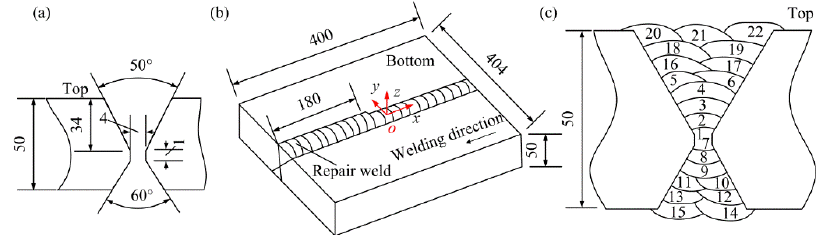
Figure 1. Schematic diagram of the specimen. ( a ) Groove configuration; ( b ) dimensions; ( c ) welding sequence.